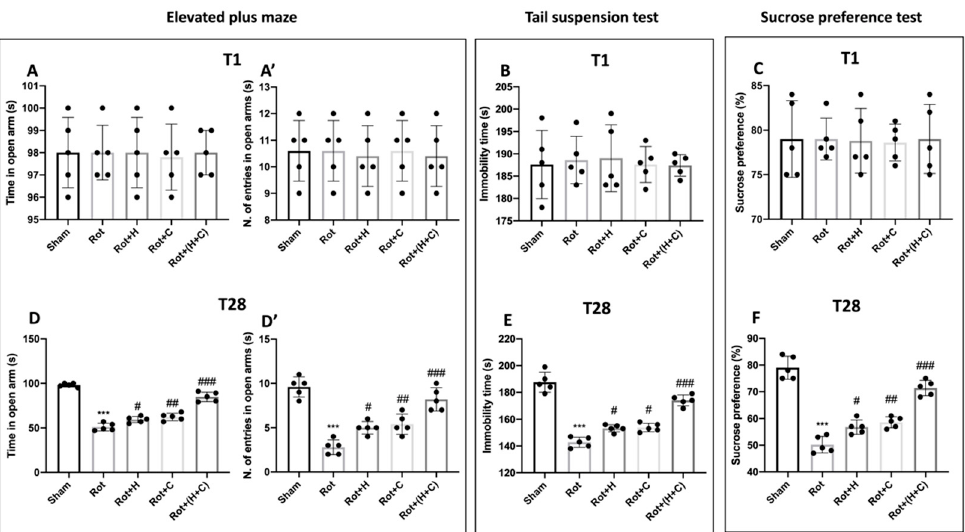
Figure 8. Effect of H or C or H+C on behavioral non-motor alterations in Rot-lesioned mice. The behavioral analysis of non-motor symptoms was assessed using EPM ( A , A’ for T1 and D,D’ for T28), TST ( B for T1 and E for T28) and SPT ( C for T1 and F for T28). The data are expressed as the mean ± SD of 5 mice for each group. *** p < 0.001 compared to Sham; # p < 0.05 compared to Rot; ## p < 0.01 compared to Rot; ### p < 0.001 compared to Rot.